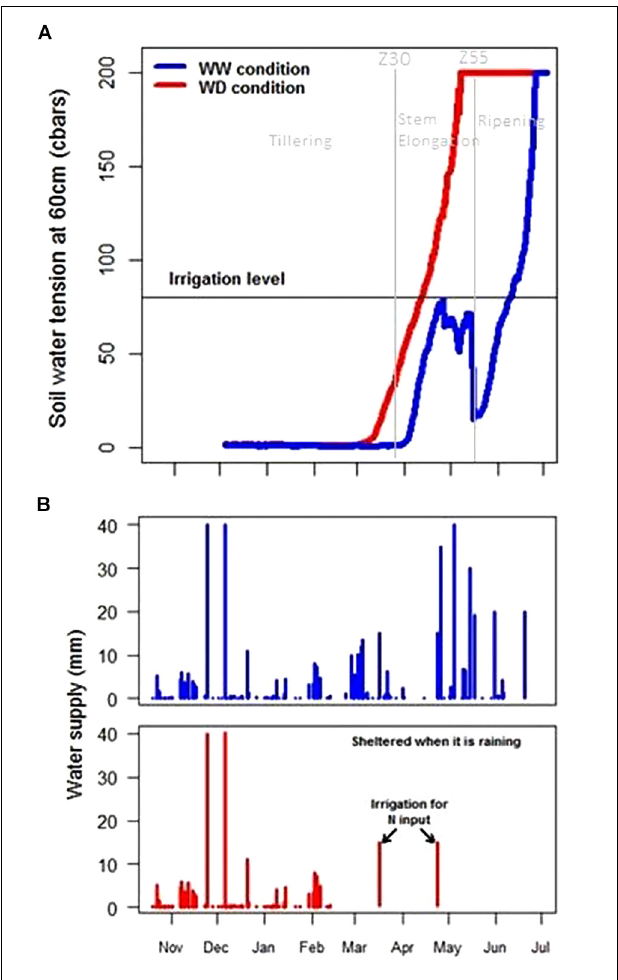
FIGURE 7 | Soil water tension at 60 cm (A) and water supply (B) in well-watered (blue) and water-deficient conditions (red) during crop